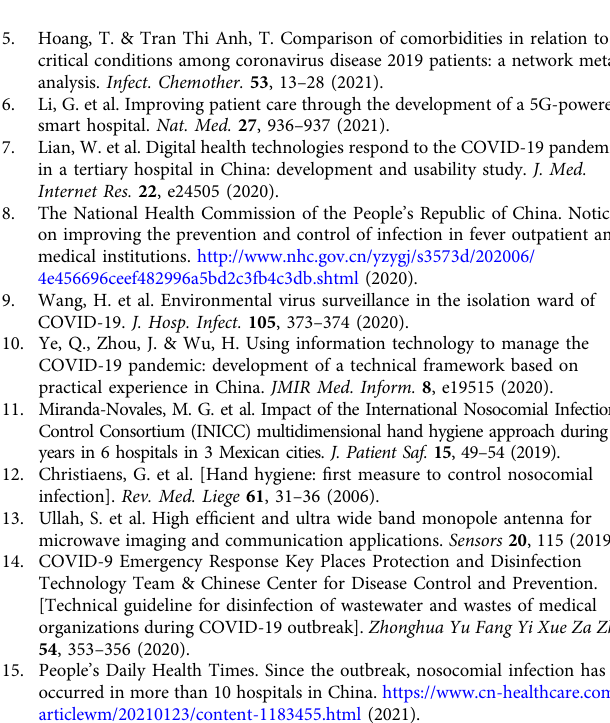
Fig. 1 The work fl ow followed by the medical hazardous waste management